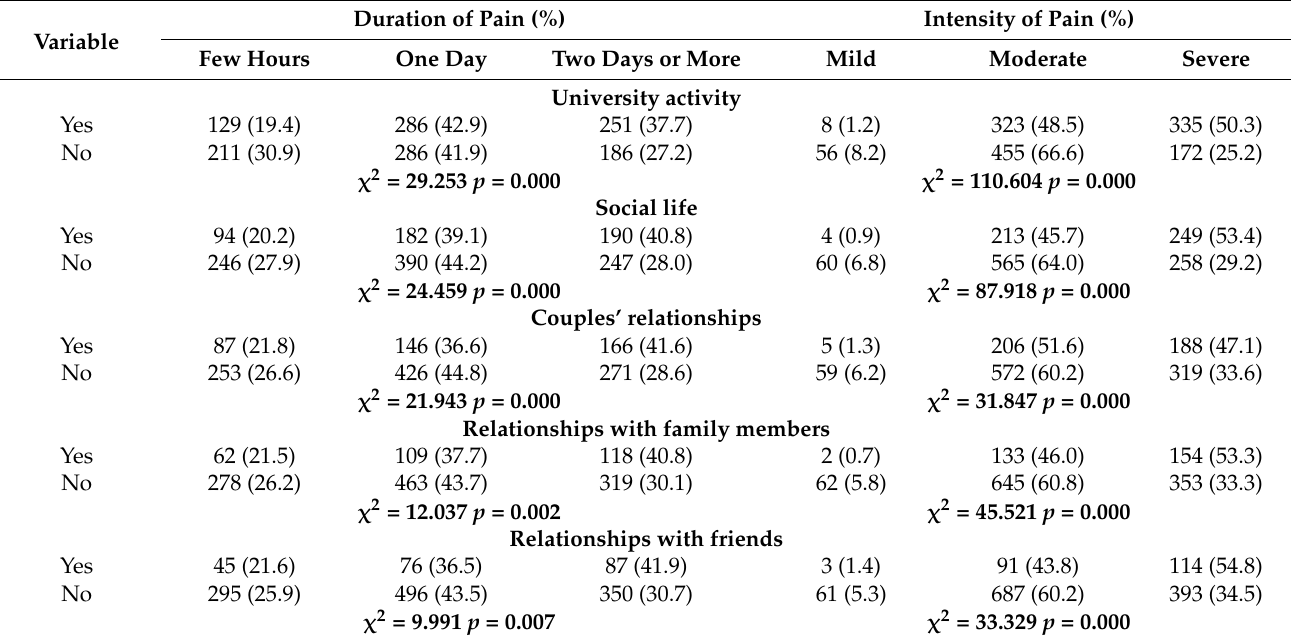
Table 5. Quality of Life and Duration or Intensity of Pain ( n =